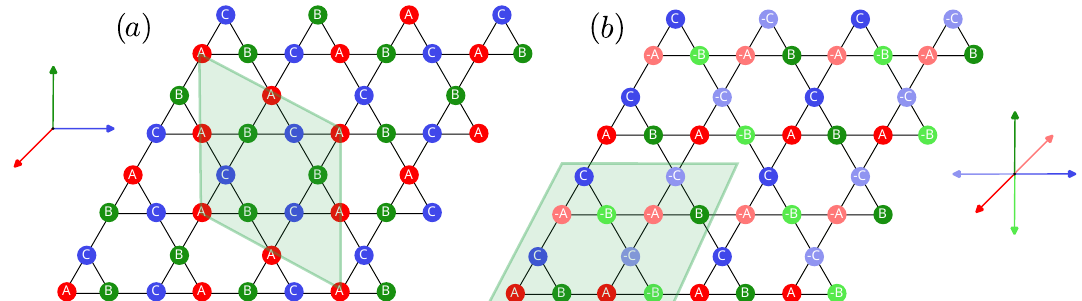
Figure 10: (a) Example of a three-color triaxial state. The directions A, B, and C form an orthogonal basis. (b) Variant of the octahedral phase with AFM chains along the diagonals of the hexagons. The axis are illustrative and not unique. The unit cell is represented by the